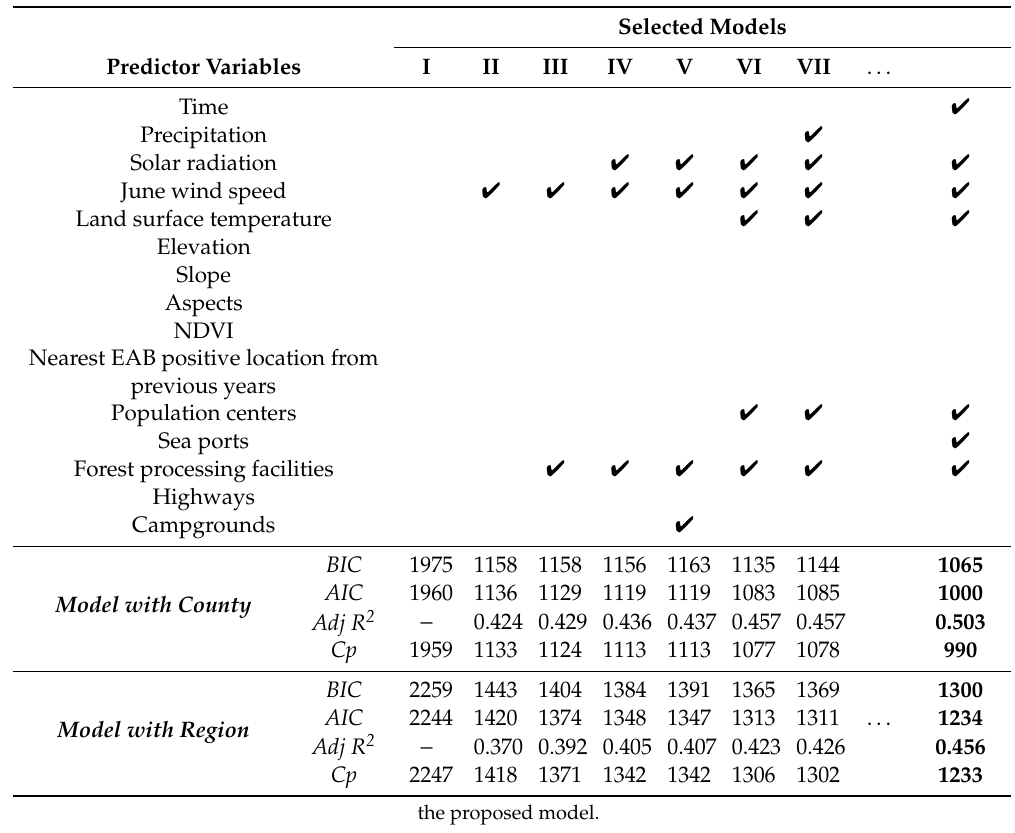
Table 5. The stepwise model selection process. In each step, one predictor with the smallest p-value was added in the model. If the estimated BIC (Bayesian Information Criterion) value decreased, that predictor variable was kept in the model, and other variables were tested in the next steps. Meanwhile, if the estimated BIC value increased as an additional variable was included, the predictor variable was dropped.